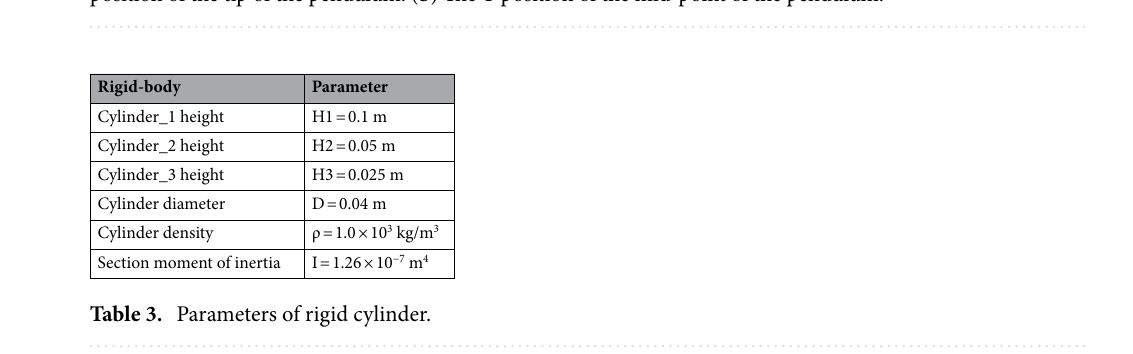
Figure 10. Comparison between simulation results and the results of former literature. ( a ) The Z versus X position of the tip of the pendulum. ( b ) The Y position of the mid-point of the pendulum.